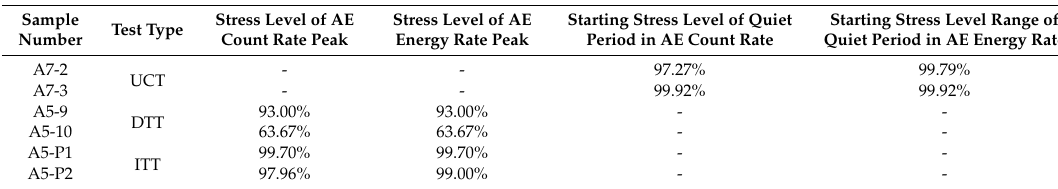
Table 4. Second precursor point before failure according to the AE parameters under the di ff erent loading